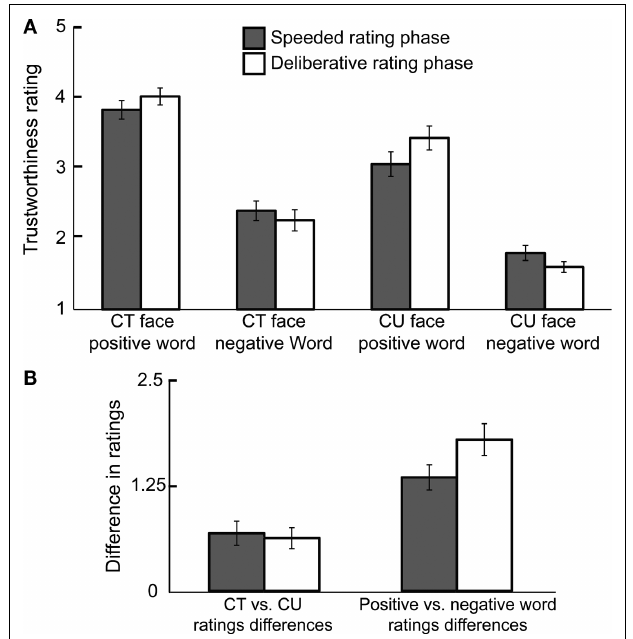
FIGURE 1 | Results from Experiment 1. (A) Behavioral judgments varied as a function of both consensus face rating and the valence of paired words. (B) The infl uence of word valence, as measured by the average difference in ratings between faces paired with positive versus negative words, was attenuated in the speed rating condition compared to the deliberative rating condition. In contrast, the infl uence of consensus face rating, as measured by the average difference in ratings between consensus trustworthy (CT) and consensus untrustworthy (CU) faces, was similar between